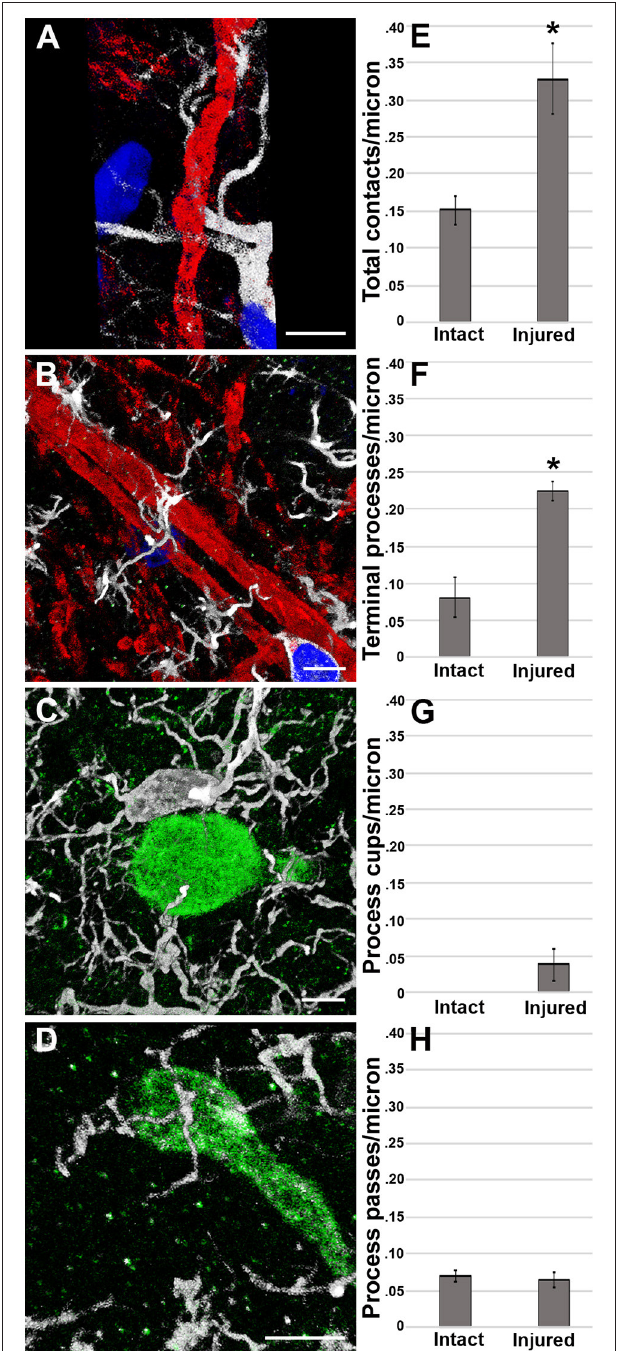
FIGURE 4 | Microglial process convergence onto injured axonal swellings occurs 1 day following cFPI in the micro pig. Representative reconstructions of (A,B) MBP + intact myelinated axons (red) or (C,D) APP + injured axonal swellings (green) and Iba-1 + microglia (white) in the thalamus of injured micro pigs 1 day post-cFPI. DAPI-labeled nuclei are in blue. Bar graphs depicting the average number of (E) total microglial process contacts, (F) terminal processes, (G) process cups and (H) process passes of Iba-1 + microglial that contact either MBP + intact fibers or APP + injured axonal swellings 1 day